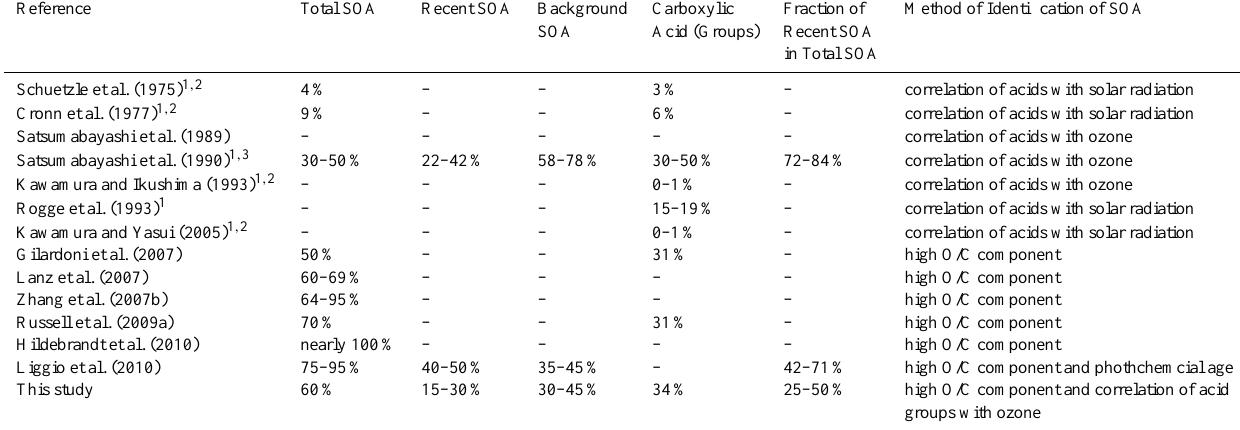
Table 4. Comparison of SOA mass fractions in this study with previous studies. Quantities include (1) OM fraction (PM fraction if specified) of “Total SOA”, (2) OM fraction of “Recent SOA” (SOA formed within 1 day or 2 days), (3) OM fraction of “Background SOA”, (4) OM fraction (PM fraction if specified) of carboxylic acid (groups), and (5) fraction of “Recent SOA” in “Total